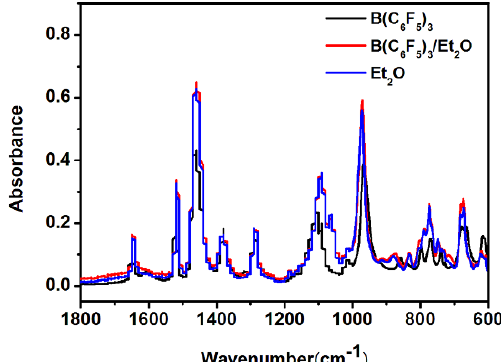
Figure 1. ATR-FTIR spectra for the interaction between B(C 6 F 5 ) 3 and Et 2 O at 20 ◦ C. [B(C 6 F 5 ) 3 ] = 0.05 M; [Et 2 O] = 0.1